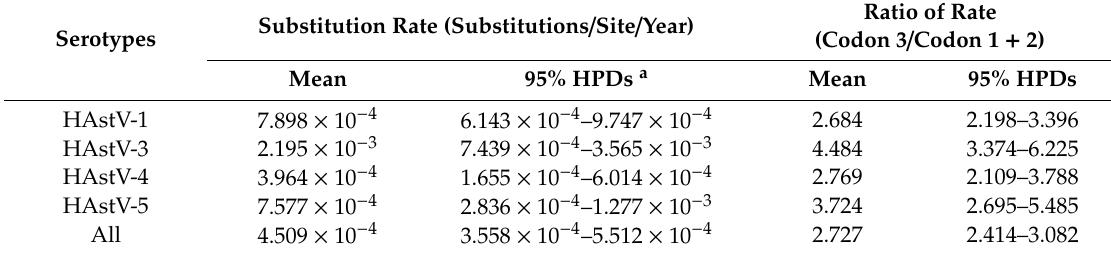
Table 2. Evolutionary rate and ratio of substitution rate at the third codon/first+second codon positions. 95% highest posterior densities [HPDs]. Serotypes